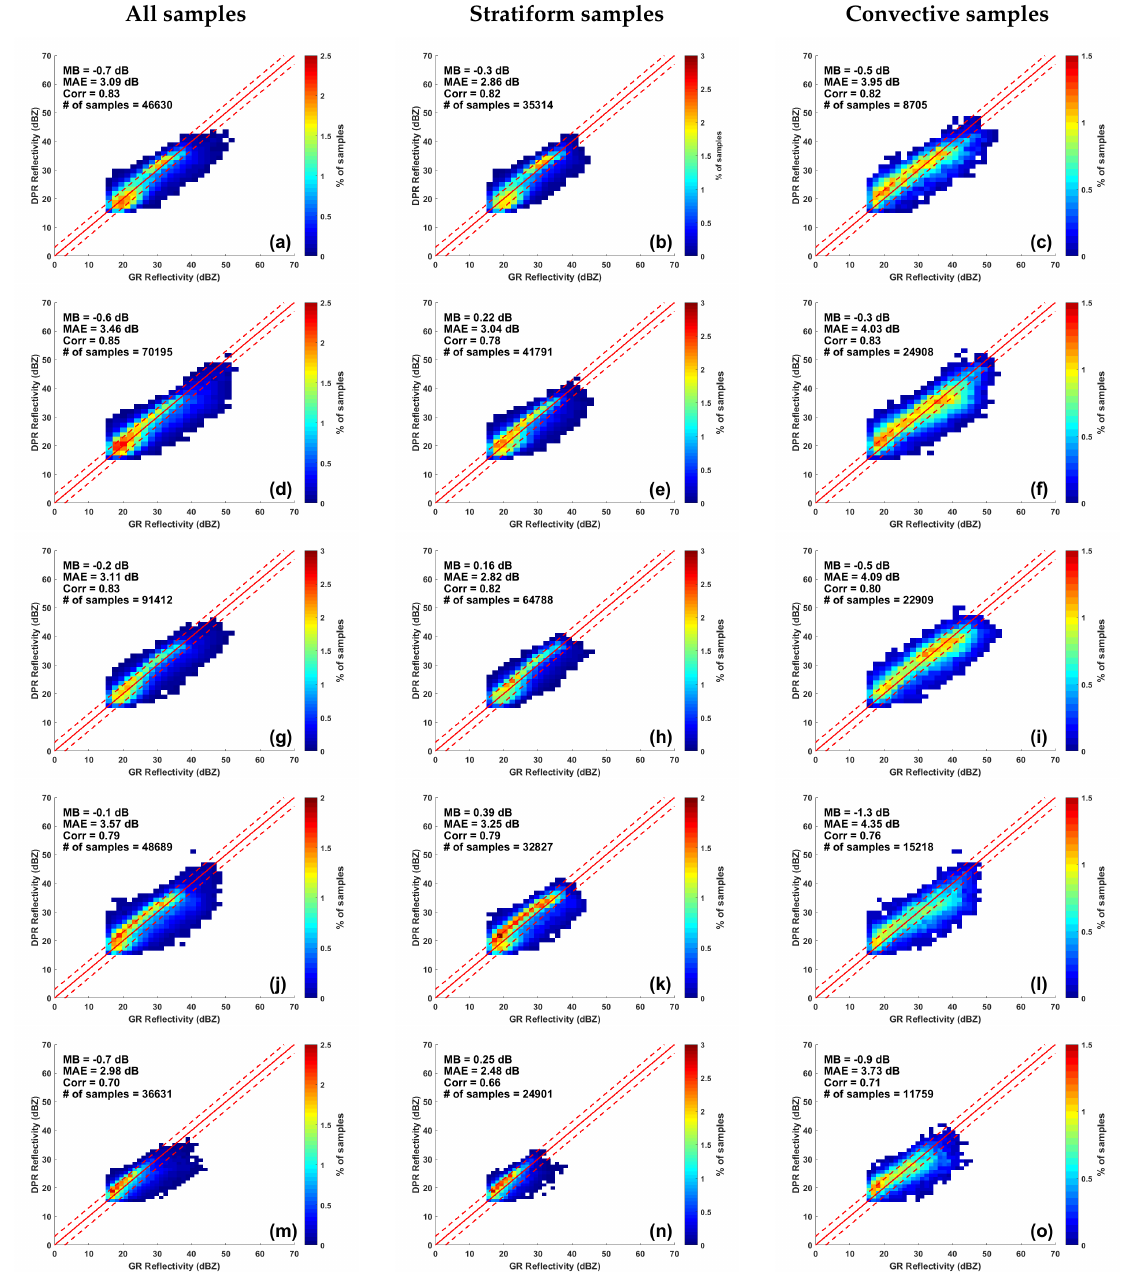
Figure 5. Same as Figure 4 but for GPM-DPR